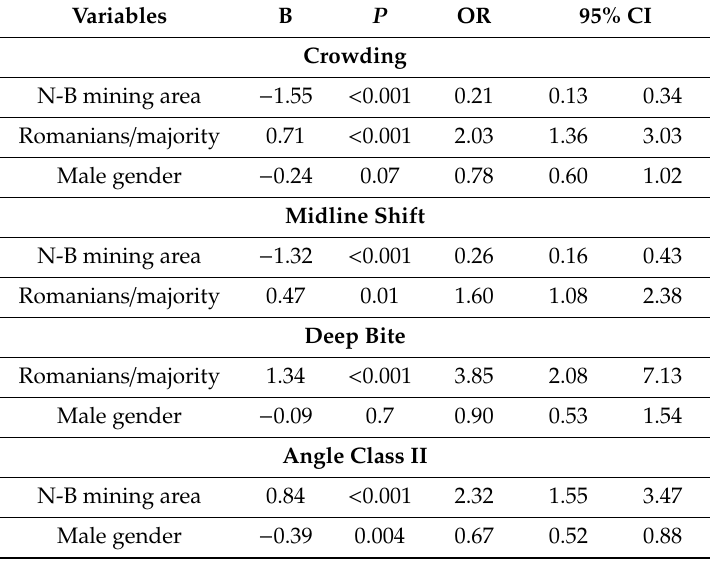
Table 5. Multivariate analysis for types of